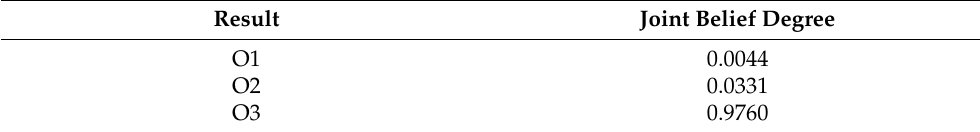
Step 4: According to the reasoning process of intervals-BRB in Section 3.2, the joint belief degree of the three outcomes is shown as in Table A4. Table A4. The rule weight, rule reliability and belief degree of the proposed model after training. Result